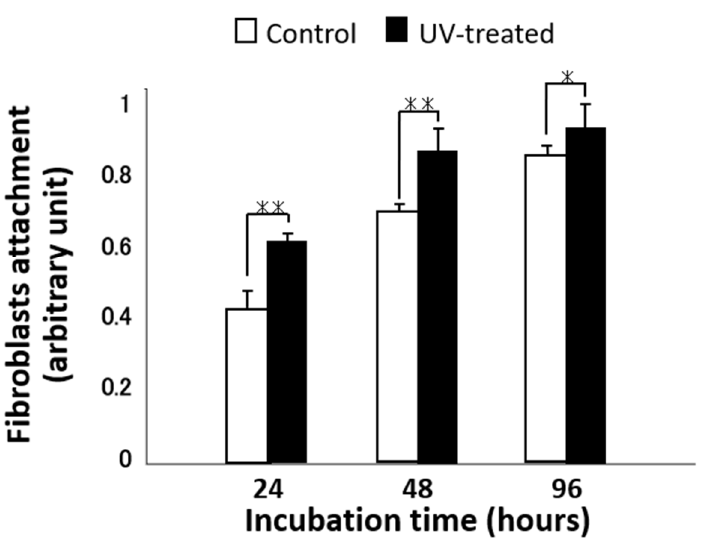
Figure 4. Total number of attached fibroblasts cultured for 24, 48, and 96 h on titanium disks with and without UV treatment. Data are mean ± SD ( n = 6). ** p < 0.01, * p < 0.05, statistically significant difference between the control and UV-treated surfaces.